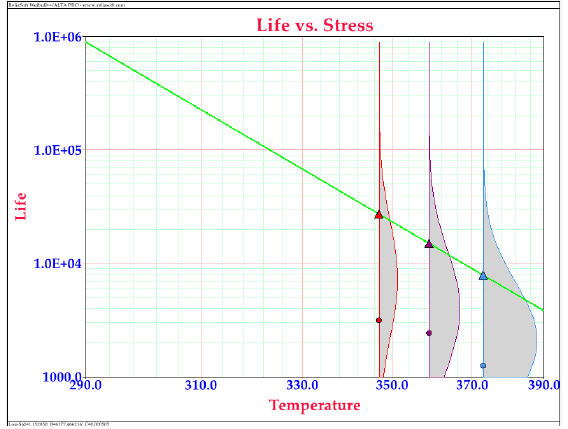
Figure 10. Lifespan and stress graph.